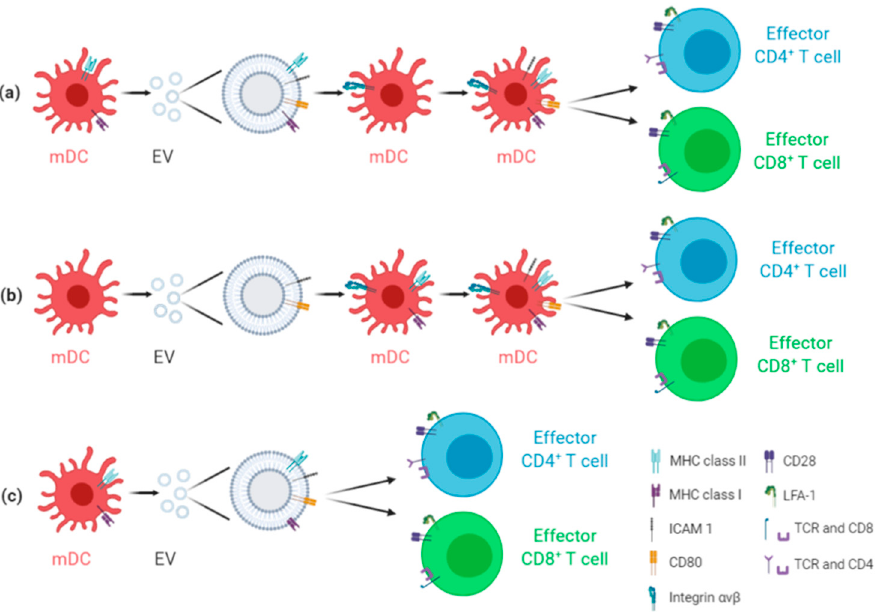
Figure 2. EVs and acquired immunity. EVs from mature dendritic cells (mDCs) can promote T-cell activation through different processes. ( a ) Cross-dressing pattern model: mDCs, once-captured EVs, expose on their surface the antigen-MHC complex promoting the activation of CD4+ or CD8+ T cells. EVs transfer the peptide–MHC complex between different populations of mDCs. ( b ) Cross-presentation pattern model: mDCs expose the EV-delivered antigens on their own MHC complex to activate CD4+ or CD8+ T cells. ( c ) Direct EV-induced T-cell activation model: EVs, released by mDCs, present on their surface the MHC class I and II molecules and directly activate CD4+ or CD8+ T. Created with BioRender.com.